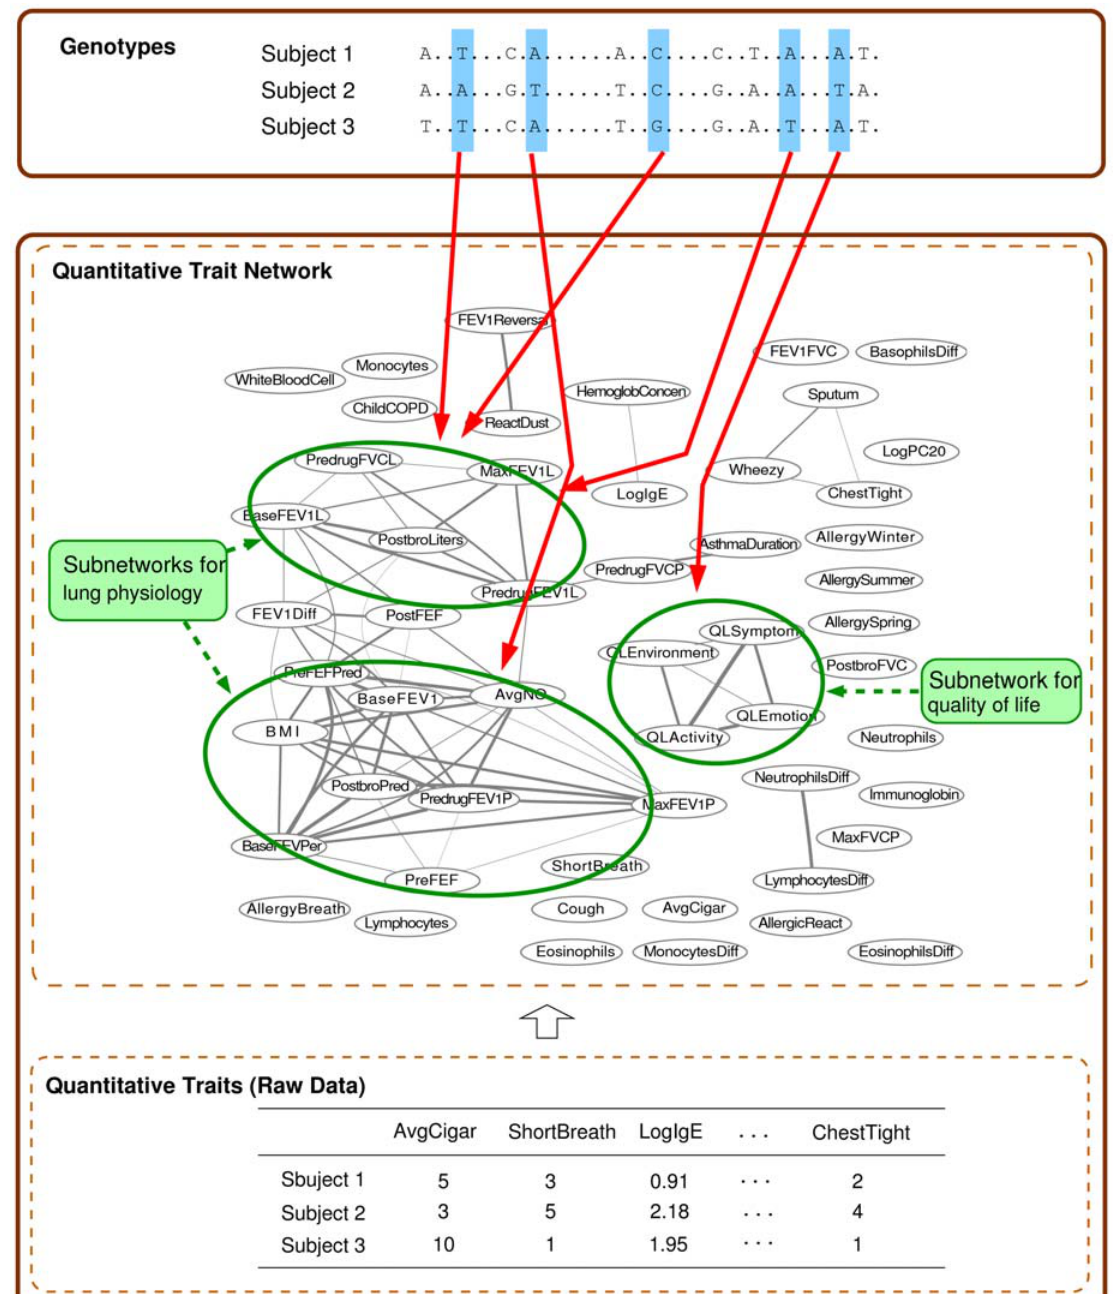
Figure 1. An illustration of association analysis using the QTN for asthma dataset. Nodes in the QTN represent clinical traits related to asthma. Each pair of nodes is connected with an edge if the corresponding two traits are highly correlated. The thicknesses of edges indicate the strength of correlation. We are interested in identifying SNPs that are associated with a subnetwork of clinical traits. doi:10.1371/journal.pgen.1000587.g001 weak correlations, heterogeneous (e.g., positive or negative) correlations, and pathways, etc. For example, the QTN of asthma-related traits in Figure 1 contains a large subgraph on the left which again contains two groups of densely connected traits. This hierarchical grouping information will be lost if we simply apply a clustering algorithm.